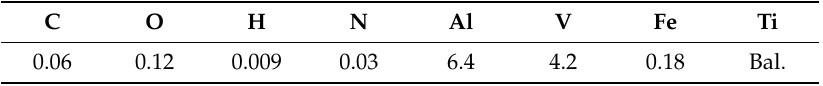
Table 2. TC4 titanium alloy mechanical properties.